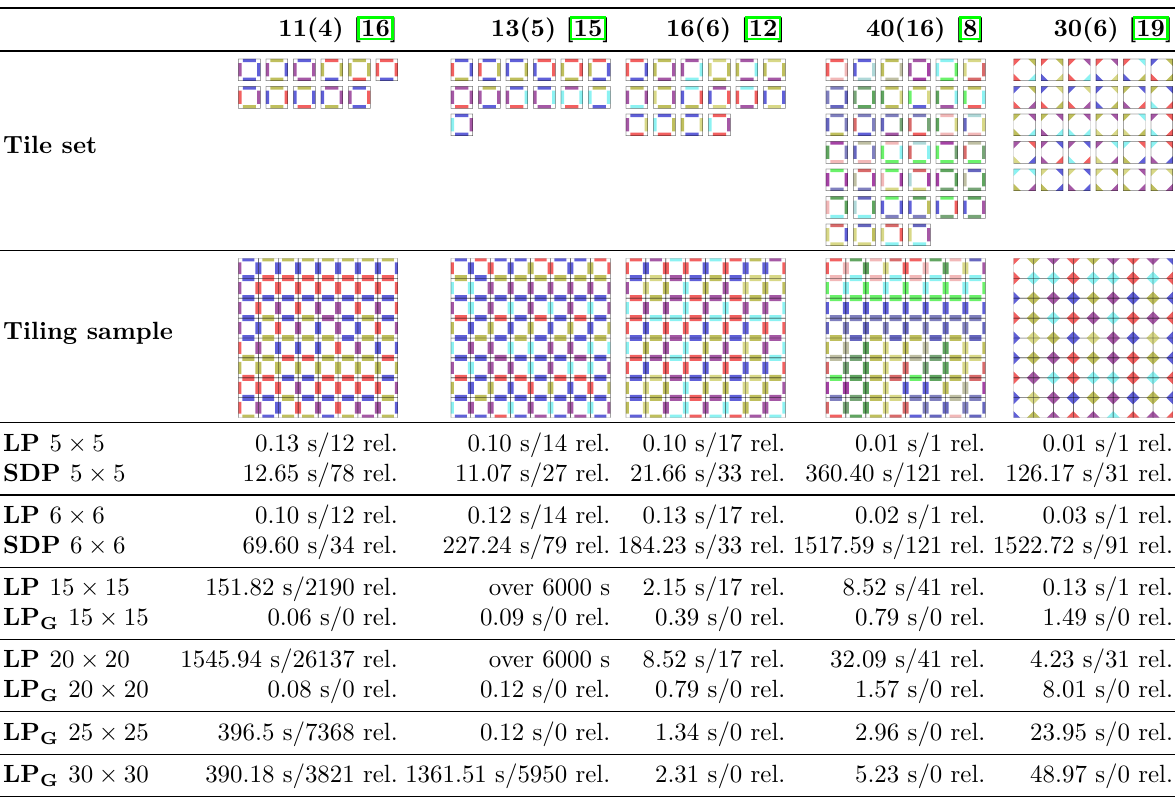
Table 1. Time demands and solved relaxations count in generation of aperiodic tilings. LP and SDP denote custom developed branch and bound method supplied with the linear and semidefinite relaxation, respectively; LP G stands for Gurobi cut-and-branch method and the linear